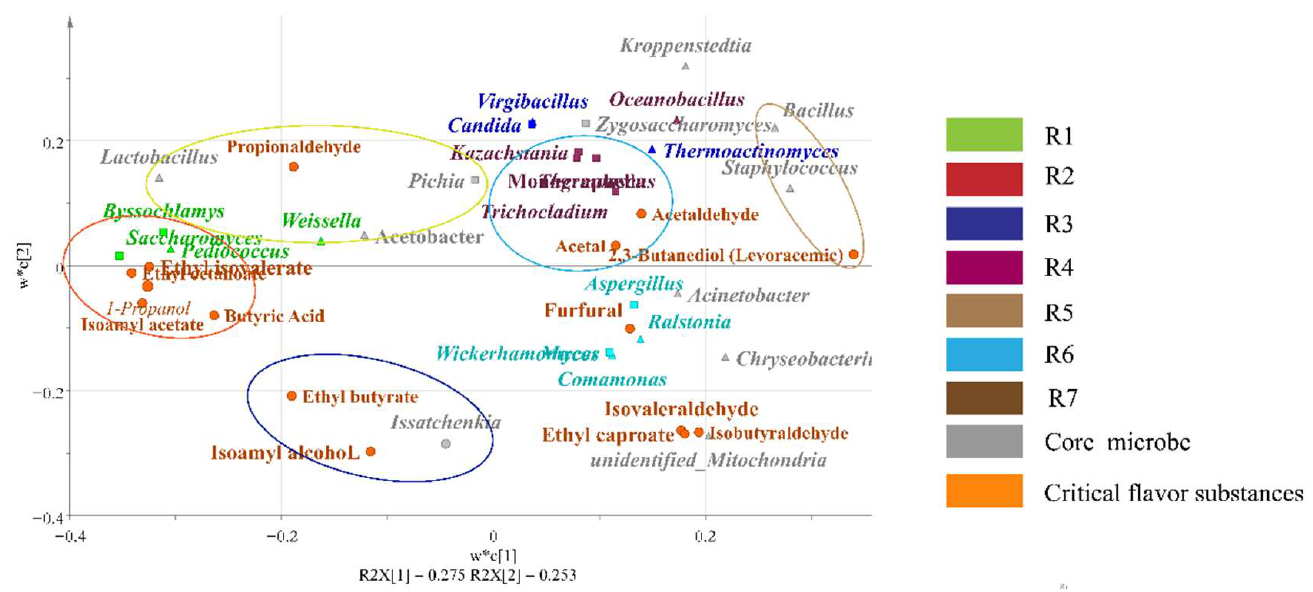
Figure 6. Analysis of the microorganisms of the pre-pit fermentation grains in different rounds and key flavor substances using partial least squares regression methods. (Triangles represent bacteria, squares represent fungi, and orange circles represent key flavor substances; seven colors represent seven rounds: